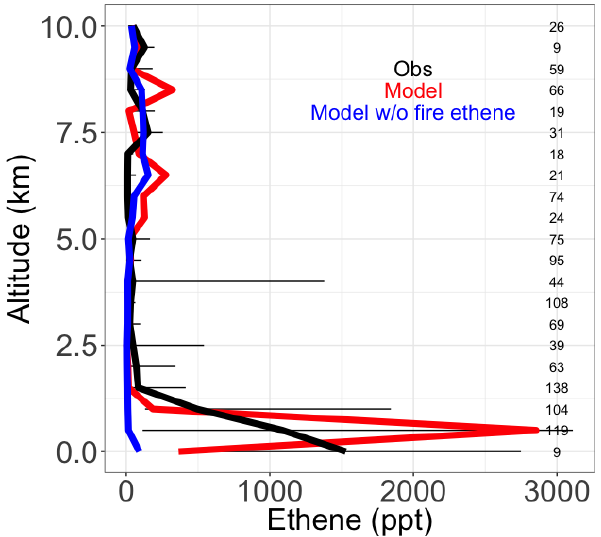
Figure 4. Median vertical profiles of binned ethene mixing ratios, including observed (black), simulated (red), and simulated in a sen- sitivity model run without fire ethene emissions (blue) during the boreal part of the ARCTAS campaign. Horizontal bars show the 25th–75th percentile range of measurements in each vertical 0.5km bin. The number of observations in each vertical bin is shown on the right side of each